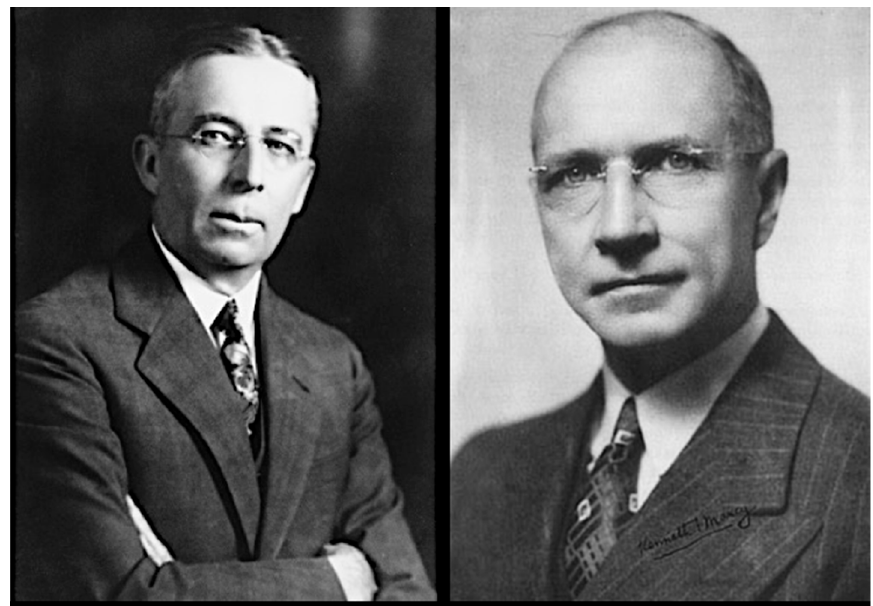
Figure 1. The Pioneers. (Left) James E. Paullin. Paullin described the first cases of flea-borne typhus (FBT) in 1913 while at Grady Hospital in Atlanta, GA. Paullin later served as physician to President Franklin Roosevelt [82]. (Right) Kenneth F. Maxcy of the US Public Health Service. Maxcy was among